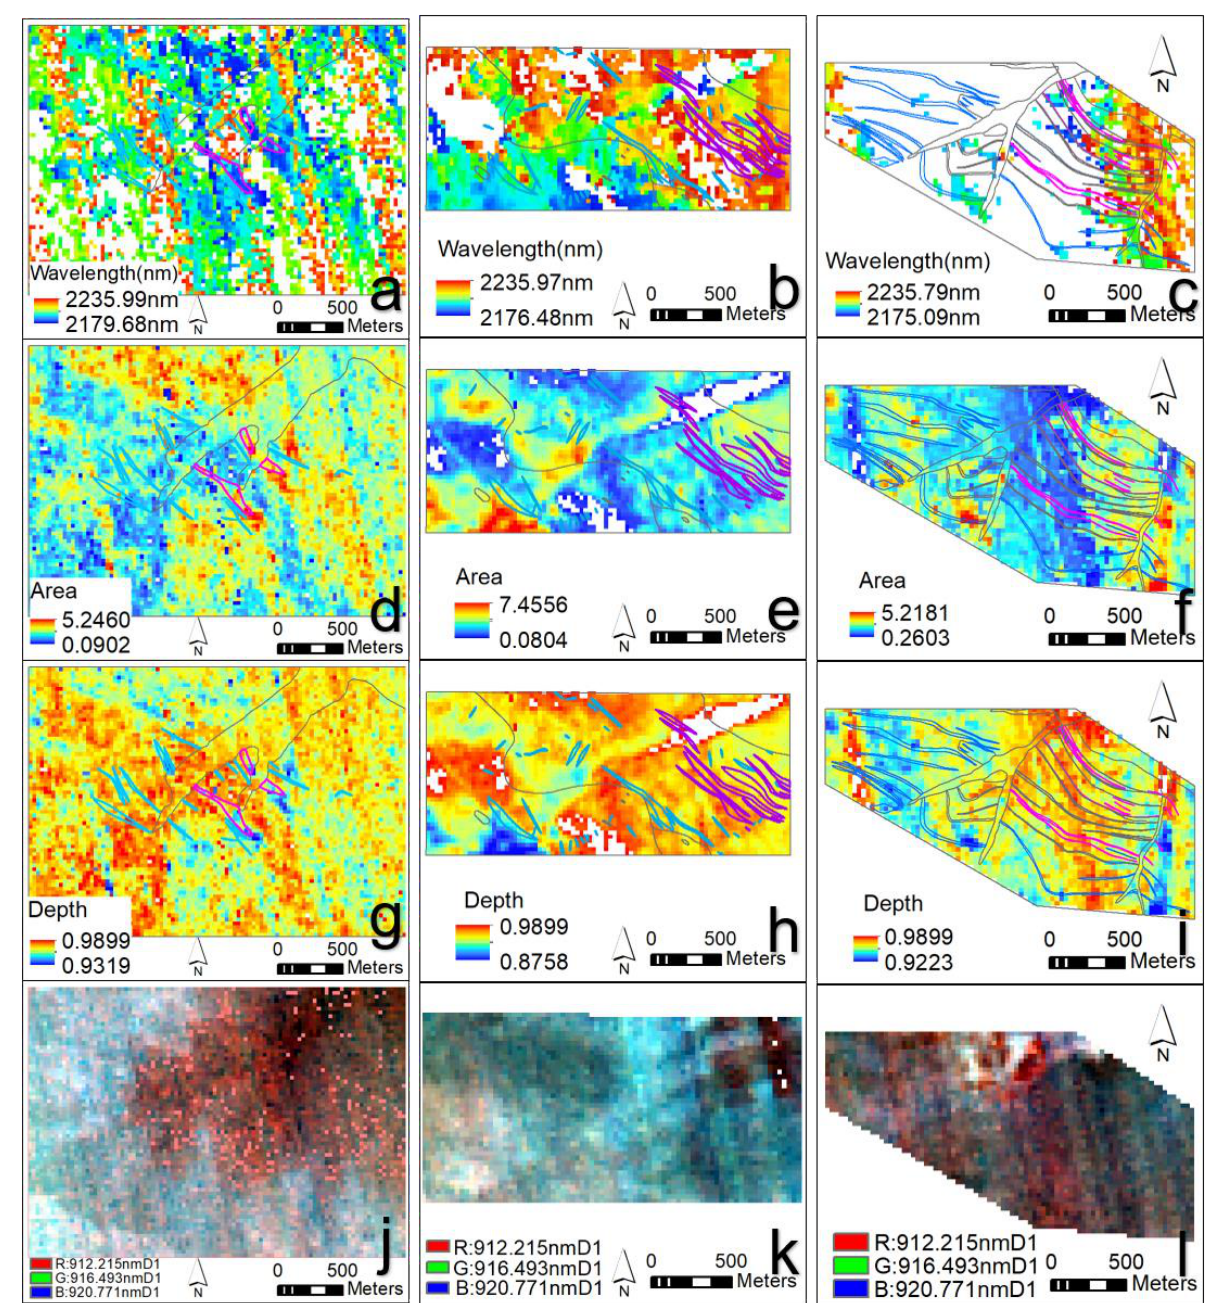
Figure 14. Predictor map (around the 2200 absorption wavelength position) of the: ( a ) Akesayi mine, ( b ) 509 mine, ( c ) Longmengshan mine, 2200 Area, ( d ) Akesayi mine, ( e ) 509 mine, ( f ) Longmengshan mine (absorption depth of around 2200), ( g ) Akesayi mine, ( h ) 509 mine, and ( i ) Longmengshan mine, and the first-order derivative of the bands of the ( j ) Akesayi mine, ( k ) 509 mine, and ( l ) Longmengshan mine).